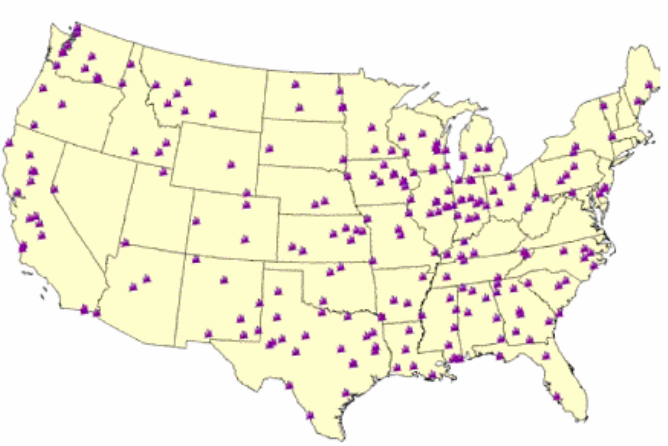
Figure 1. U.S. Mesopolitan